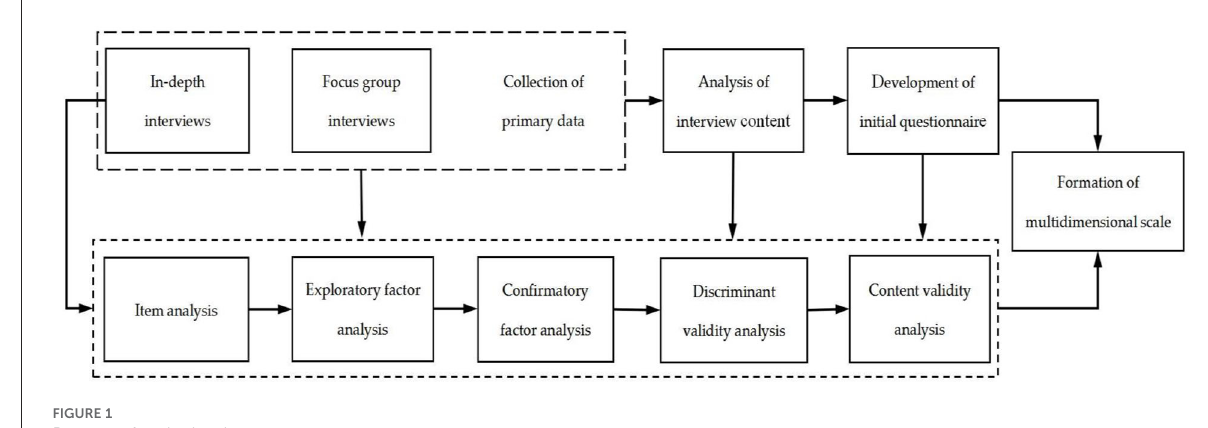
FIGURE1 Process of scale